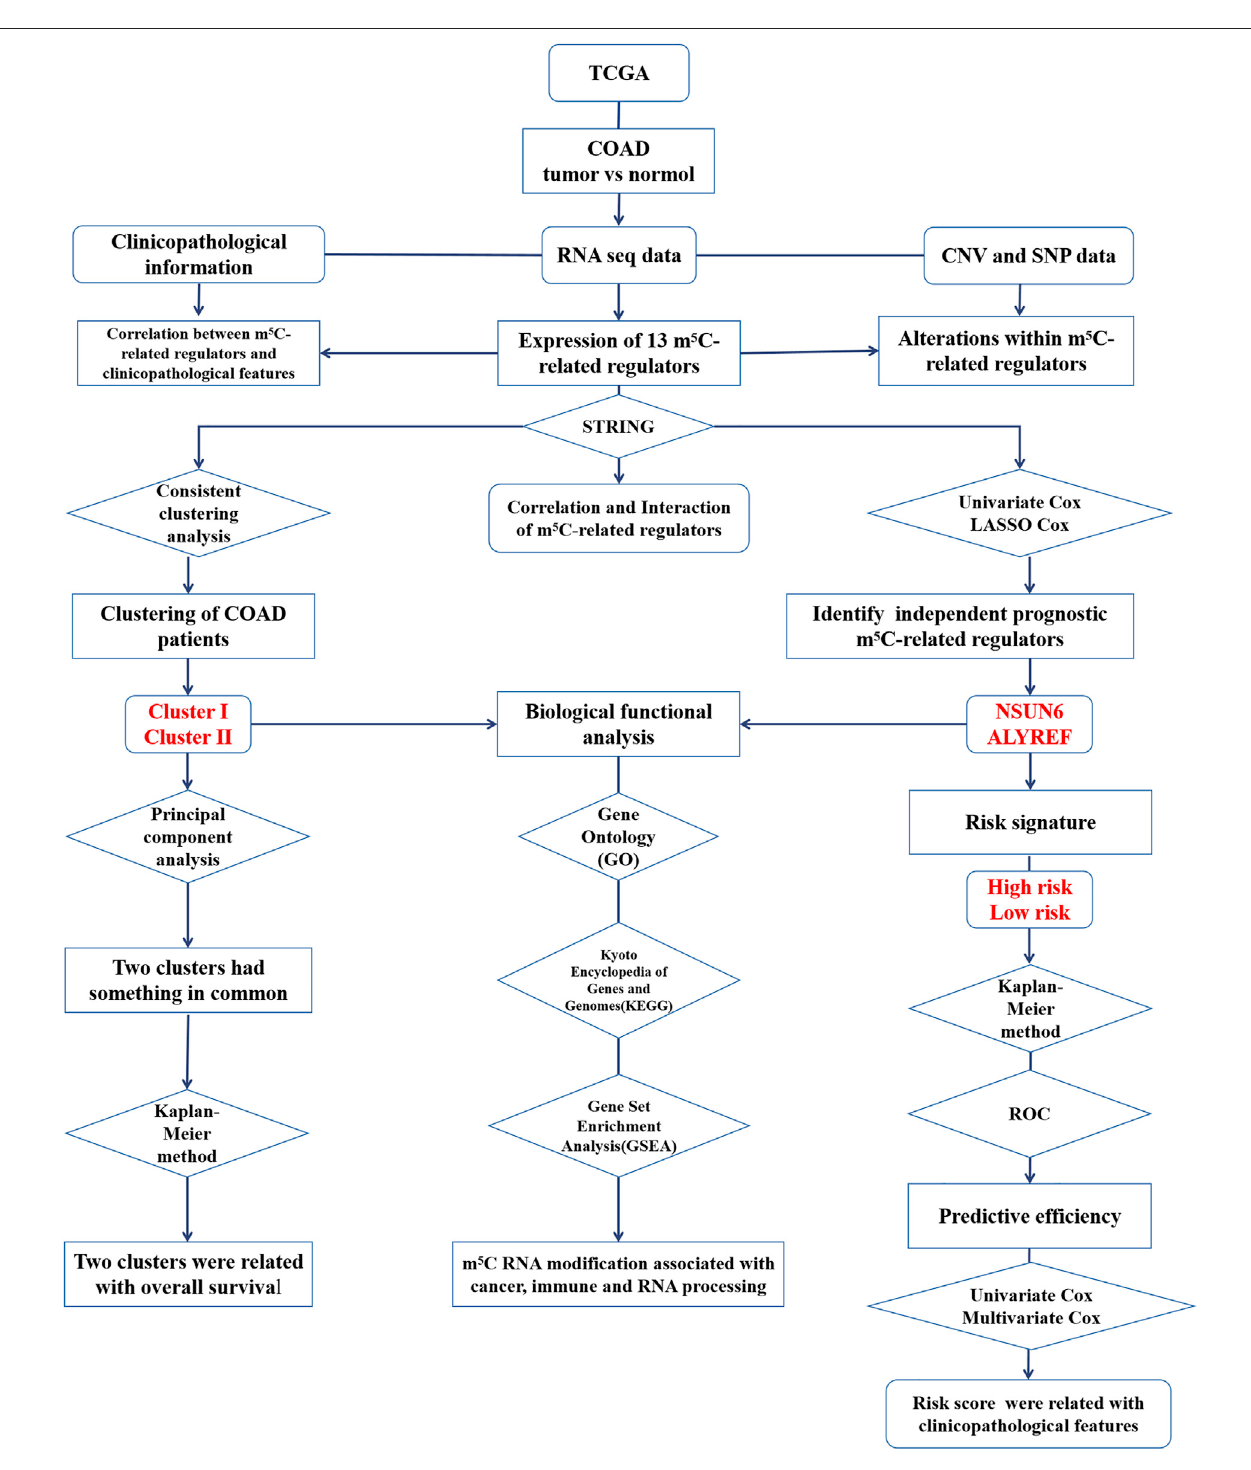
FIGURE 1 | The fl ow chart of the study design and